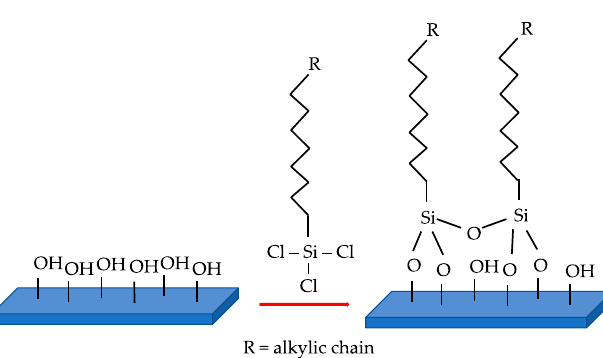
Figure 3. Example of trichlorosilane grafting procedure on surface hydroxyl groups.